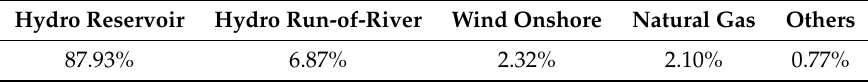
Table 7. Percentage of resources used during peak and off-peak hours in Norway